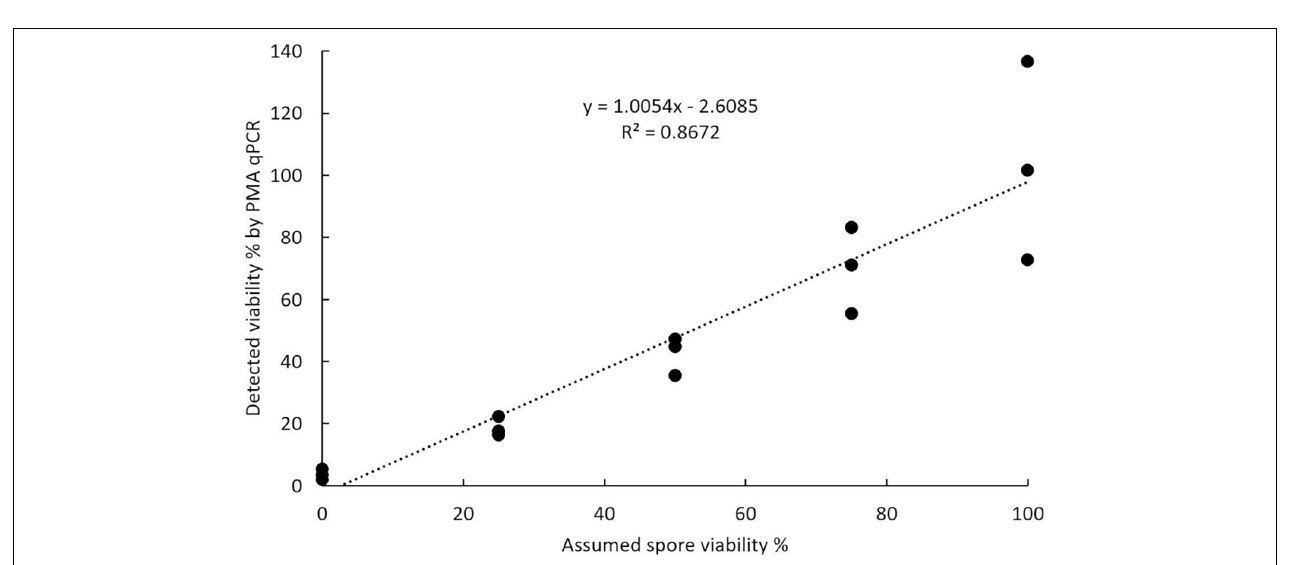
FIGURE 7 | Log DNA amount of Plasmodiophora brassicae resting spores quantified by qPCR with (+ PMA) or without (–PMA) propidium monoazide after different heat and chemical treatments.–PMA: total DNA amount; + PMA: DNA of viable spores. Different letters indicate significant differences among the treatments (Multi-factor ANVOA, Tukey test, P < 0.05, n = 3). Error bars indicate standard